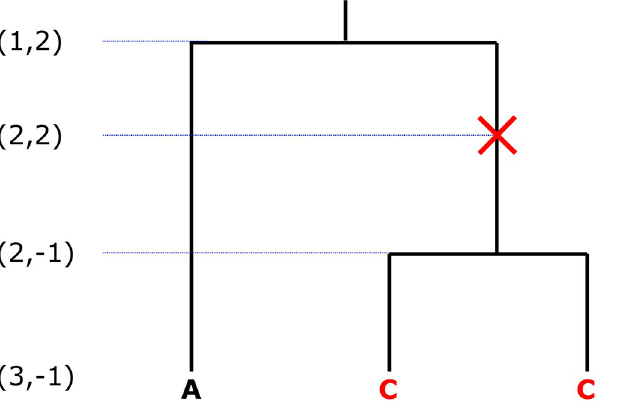
Fig 4. Example trajectory of the ancestral process with mutation for n = 3 samples with the state ( k , k � ) indicated on the left. The mutation process is superimposed onto the regular genealogical process. In this example, the mutation happens when there are two ancestral lineages, resulting in two samples carrying the derived